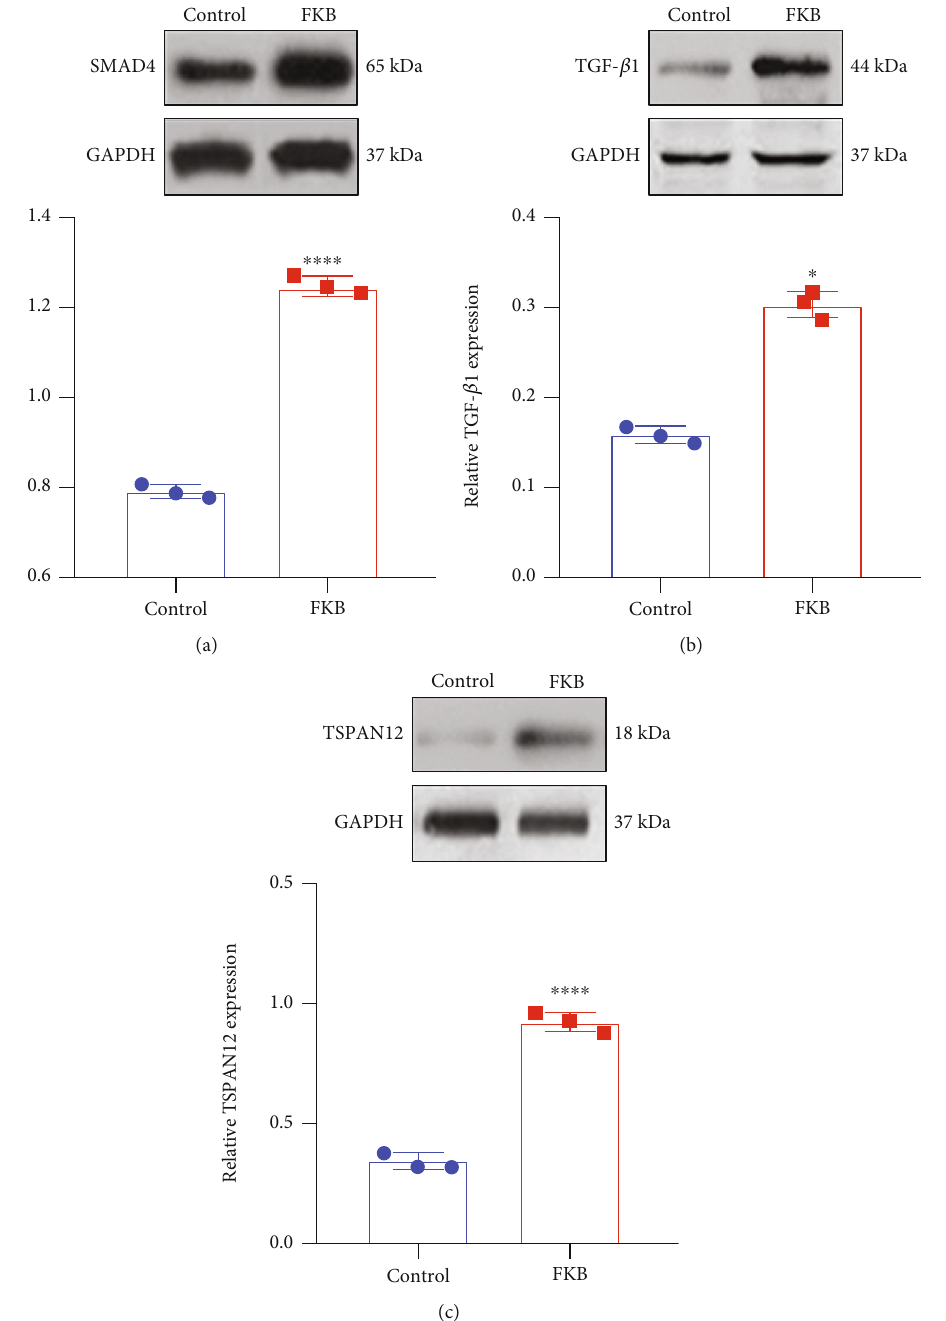
Figure 4: FKB activates the TSPAN12 expression and TGF- β 1/SMAD4 pathway in gastric cancer cells. (a) SMAD4, (b) TGF- β 1, and (c) TSPAN12 expression was quanti fi ed in SGC-7901 cells treated with FKB. ∗ p < 0 : 05 ; ∗∗∗∗ p < 0 : 0001